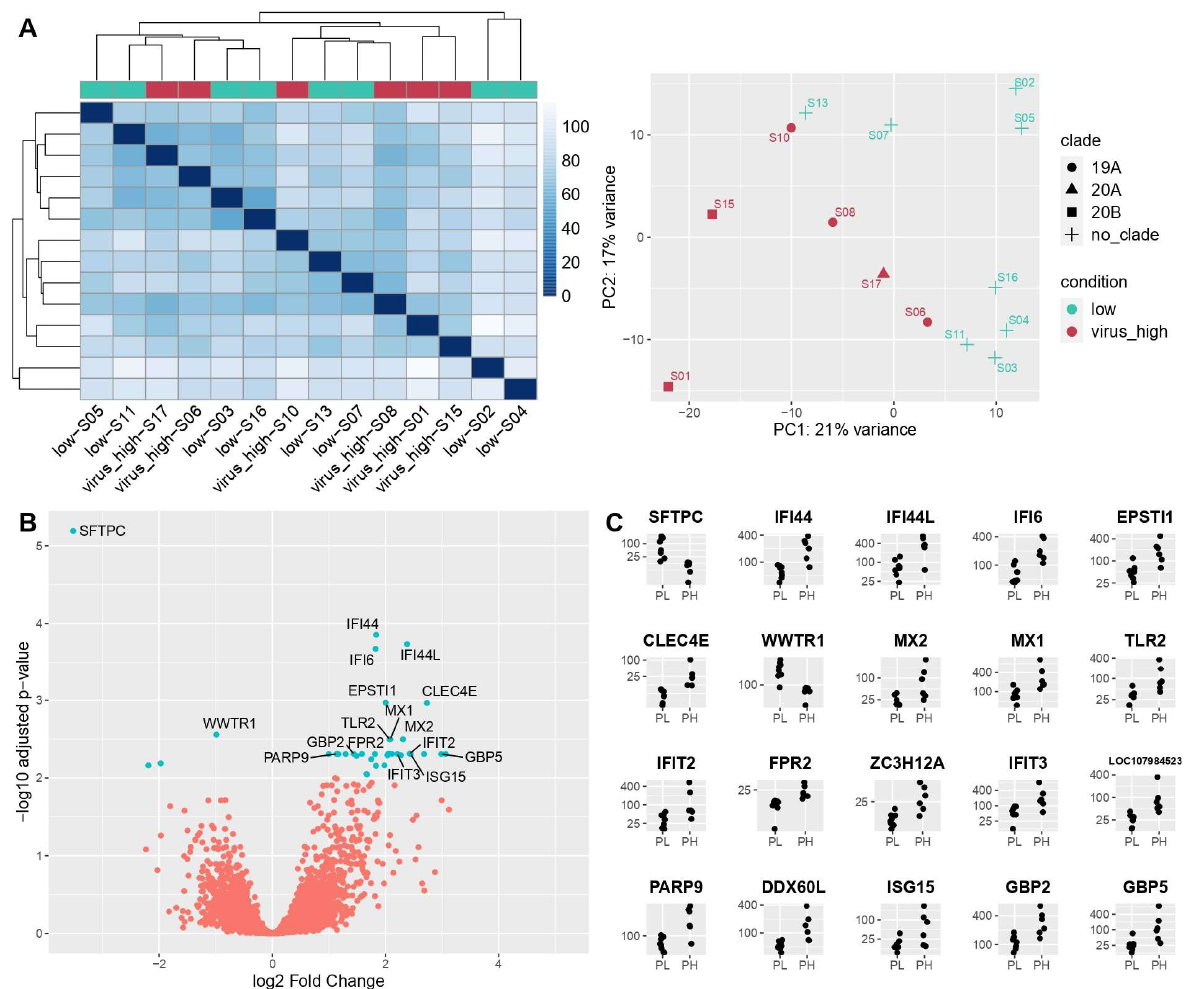
2 Figure 4. ( A ) Distance-based heatmap and PCA graph of RNA-Seq results in low-vs.-high design, showing a good segregation of the two subgroups. ( B ) Volcano plot based on RNA-Seq results of low-vs.-high design. ( C ) Top 20 DEGs in RNA-Seq in low-vs.-high